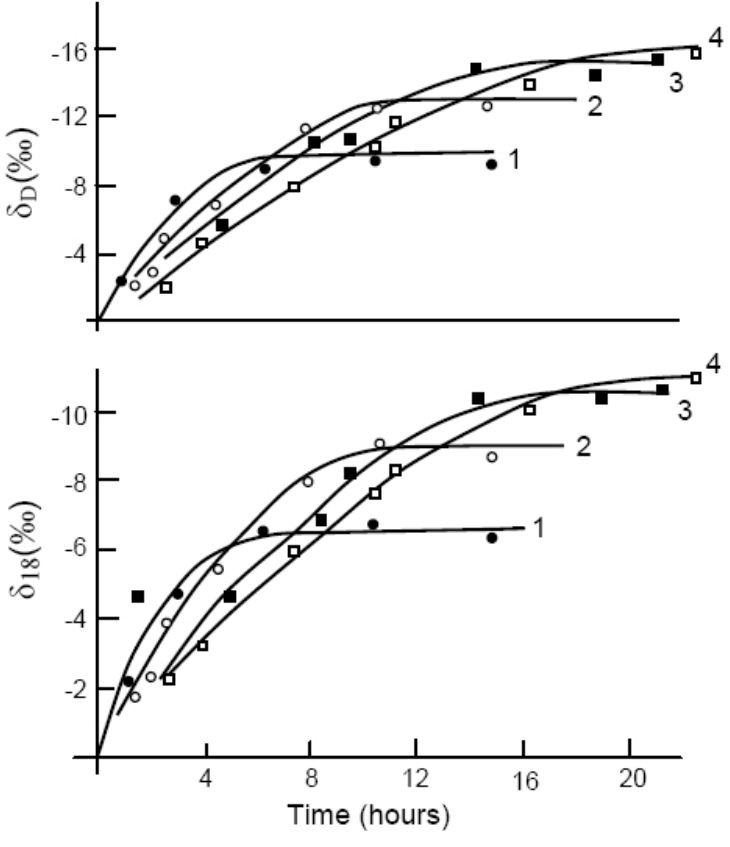
Fig. 4 Isotope separation of oxygen and hydrogen as a result of the temperature gradient across membranes of different thicknesses. Delta-values of oxygen and hydrogen changed in the hot cell over time. Installation-fig. 1, temperature in hot cell 80 ◦ C , in the cold cell 28 ◦ C. The membrane thickness: curve 1 − 30 , 2 − 75 , 3 − 150 , and 4 − 225 μ